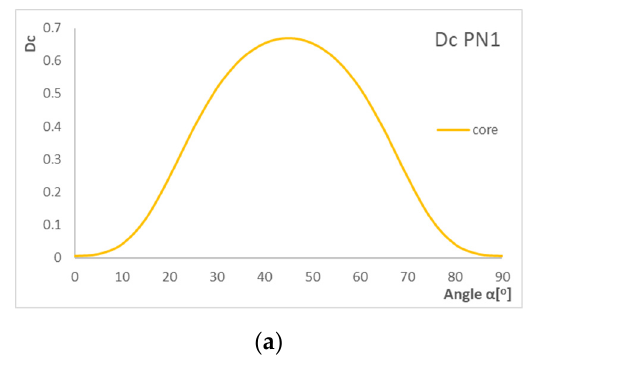
Figure 6. Influence of layer angle α in laminate with PN1 stacking sequence on D c coefficient ( a ) for core and ( b ) for strips and final configuration.